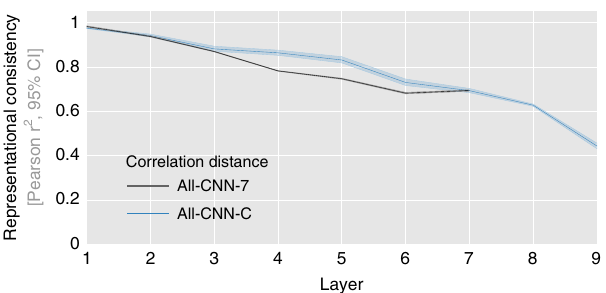
Fig. 4 Representational consistency decreases with increasing network depth. Average representational consistency for each network layer computed across all pairwise comparisons of network instances (45 comparisons for 10 instances, computed separately for two network architectures). Error bars indicate 95% con fi dence intervals (CI,